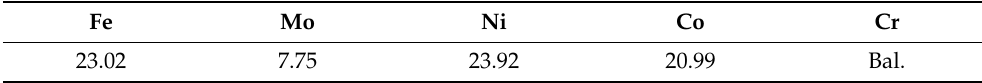
Table 1. Chemical composition of FeCoNiCrMo0.2 powder (wt.%).